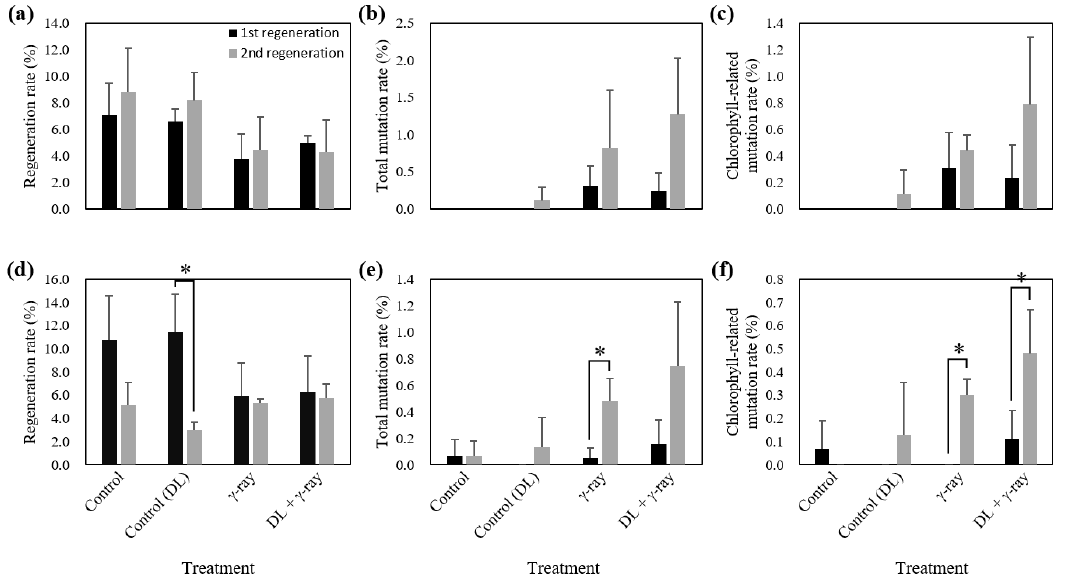
Figure 6. Regeneration, total mutation, and chlorophyll-related mutation rates of mutant populations induced by dark / light treatments followed by γ -irradiation in Cymbidium hybrids RB003 and RB012. ( a – c ) Regeneration, total mutation, and chlorophyll-related mutation rates in the RB003 population; ( d – f ) Regeneration, total mutation, and chlorophyll-related mutation rates in the RB012 population. DL, dark/light treatments. Student’s t -test was used to calculate statistical significance (* p < 0.05).